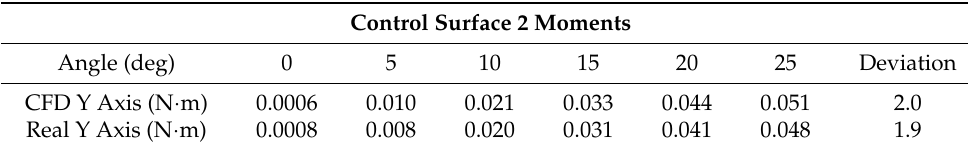
Table 6. Moments generated by Control Surface 2 at different deflection